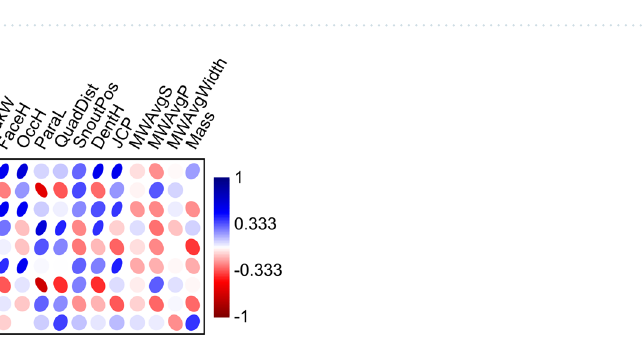
Figure 5. Time-averaged ecomorphospace for different values of k. Colour scheme: red, Ankylosauridae; green, Nodosauridae; orange, Centrosaurinae; blue, Chasmosaurinae; yellow, Hadrosaurinae; purple, Lambeosaurinae. Silhouettes not to scale.